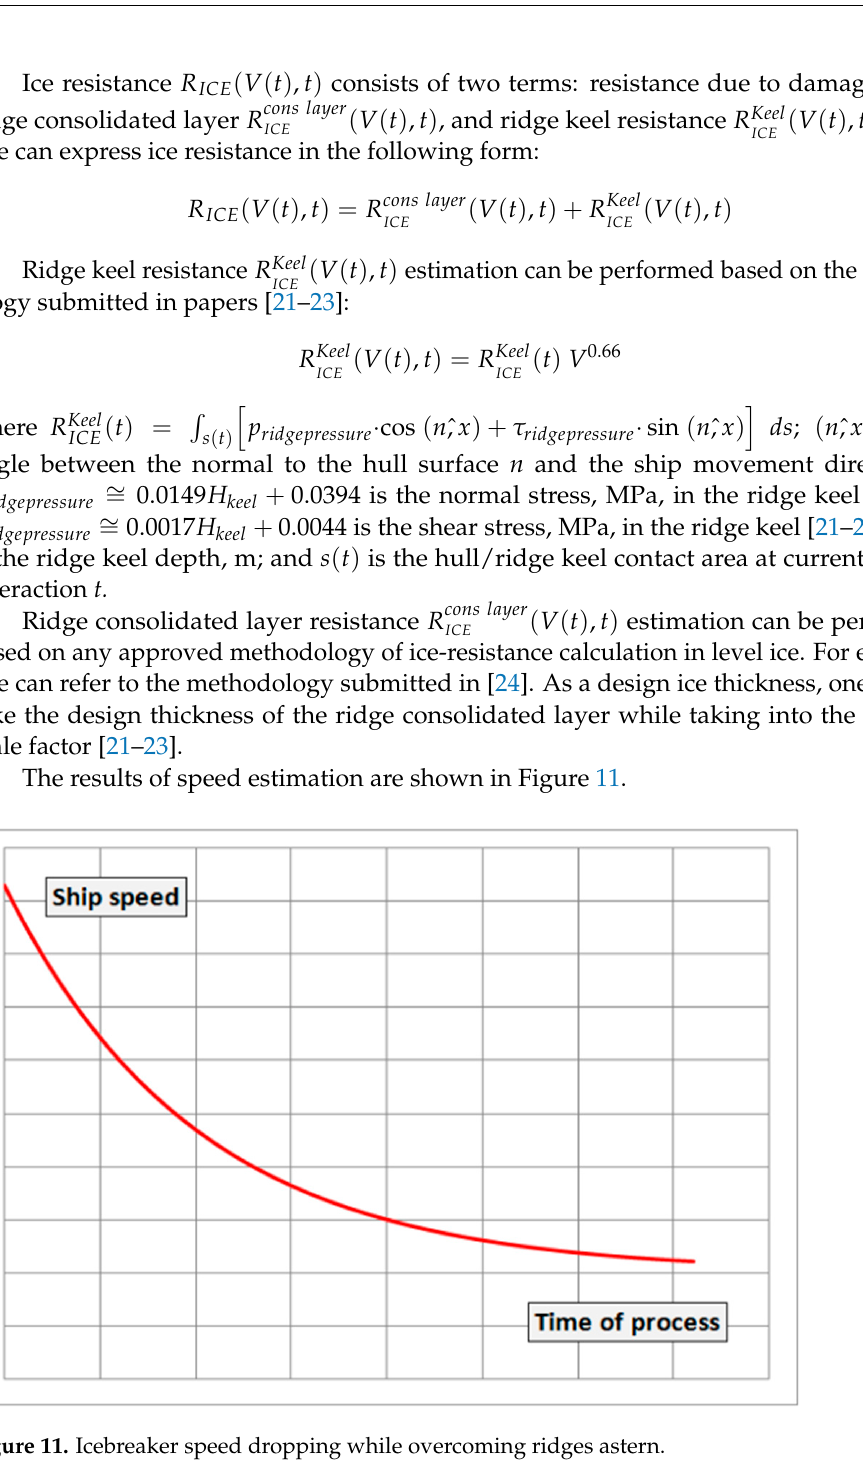
Figure 12. Ice loads and hydrodynamic torques on the propeller and MEE of azimuth unit during astern movement in ridges.